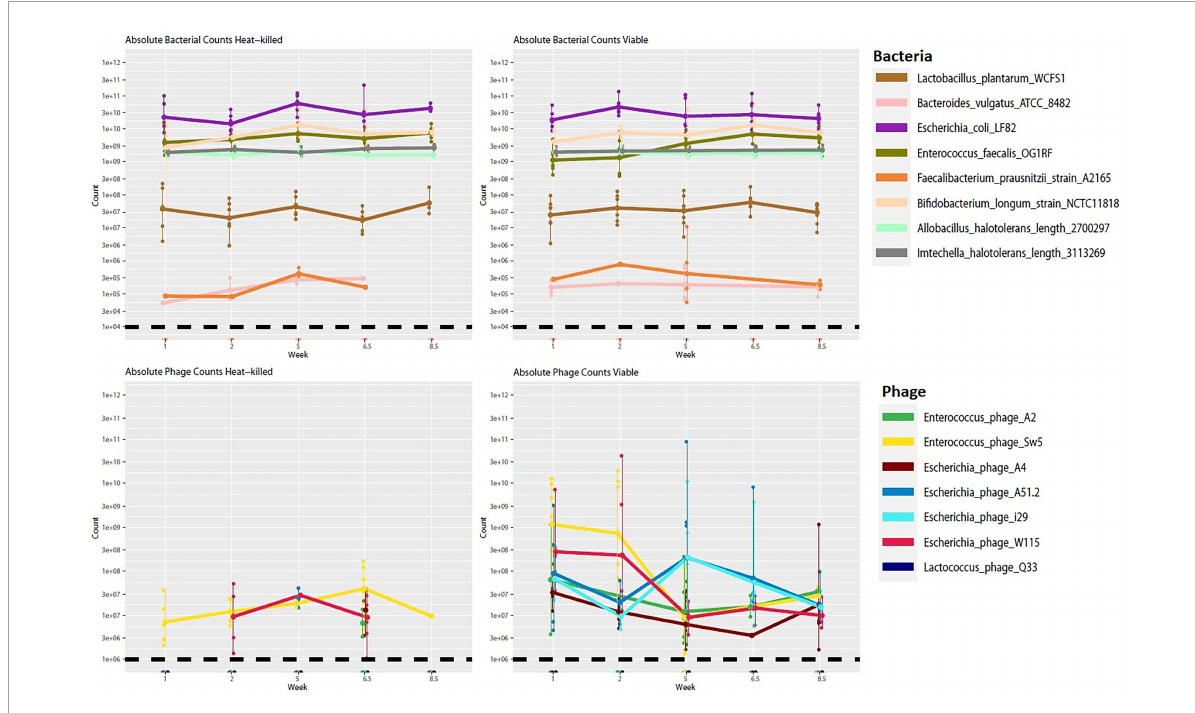
FIGURE8 Absolute abundance counts for bacterial and phage genomes across time for viable and heat-killed cohorts. Each point represents absolute genome abundance per sample. Lines are joined at the mean non-zero count for each genome. The black dashed line represents the estimated threshold of detection for hosts and phage, respectively.